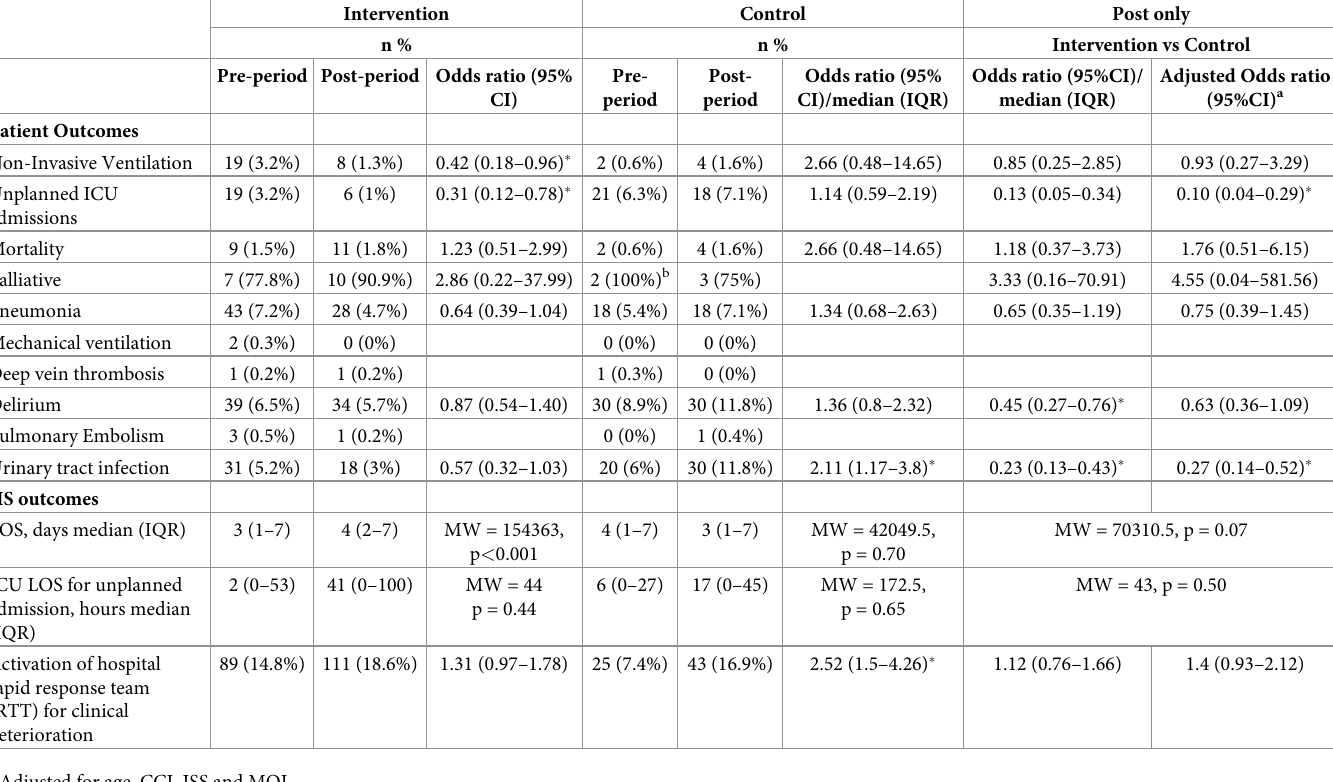
Table 2. Clinical outcomes and healthcare utilisation for intervention and control hospitals. Intervention Control Post only n % n